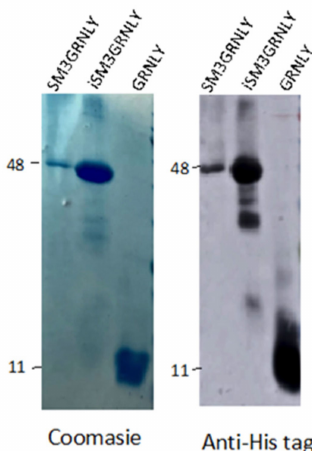
Figure 3. Coomassie staining (left panel) and anti-His tag immunoblot (right panel) of representative purified batches of SM3GRNLY, iSM3GRNLY or GRNLY, as indicated.